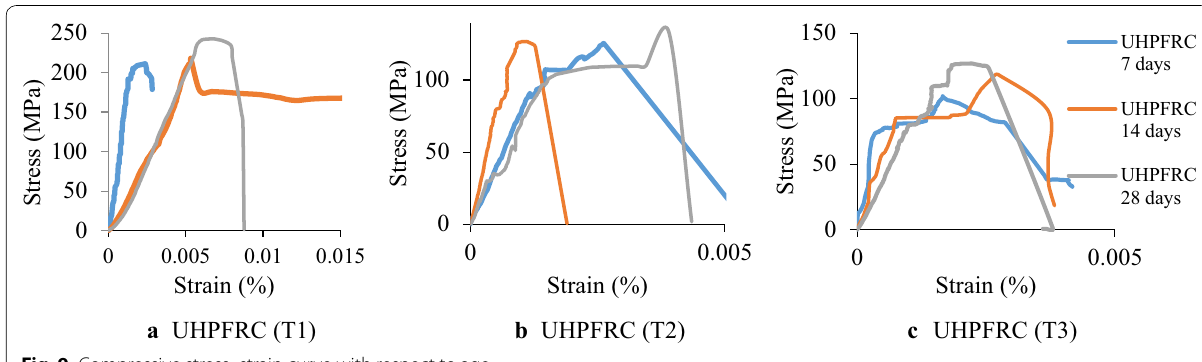
Fig. 9 Compressive stress–strain curve with respect to age